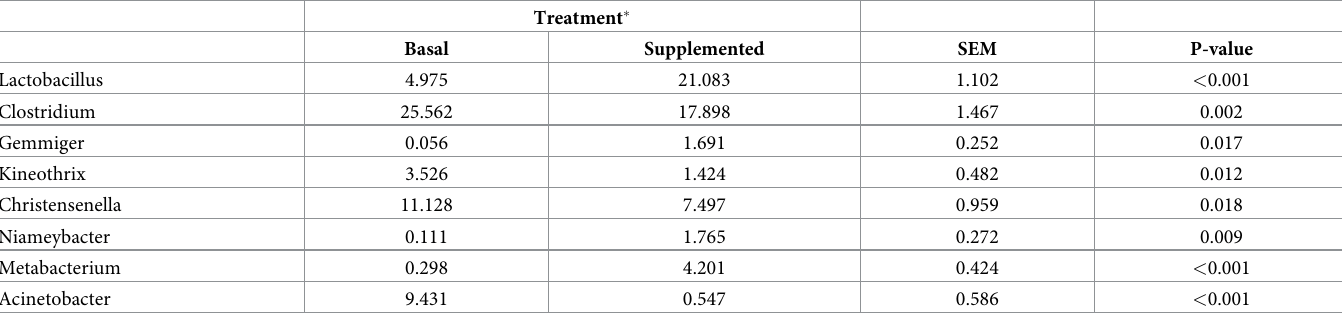
Table 9. Effect of supplementation of CH-YBG during gestation/lactation on differential relative abundance of bacterial taxa at the genus level in sow faeces on expected farrowing date. (least-square mean values with their standard error of